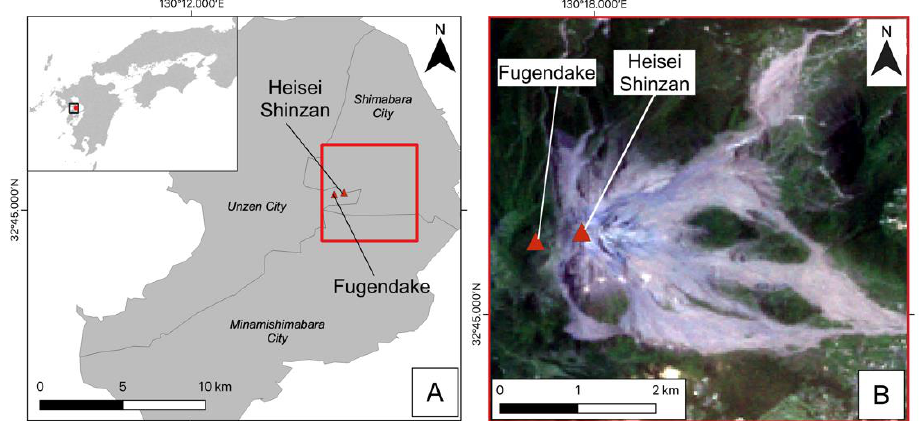
Figure 1. The Unzen volcano study site. ( A ): Location of the site (smaller red box) on the Shimabara Peninsula (grey on the main map). The inset map shows the location of the Shimabara Peninsula (black box inside inset) in southwest Japan. ( B ): Results of 1990 – 1995 eruption at the site from an RGB Landsat image taken on 6 June 1995 — A few months after the eruption had ceased. The Fugendake and Heisei Shinzan peaks are identified by red triangles in both ( A ) and ( B ).